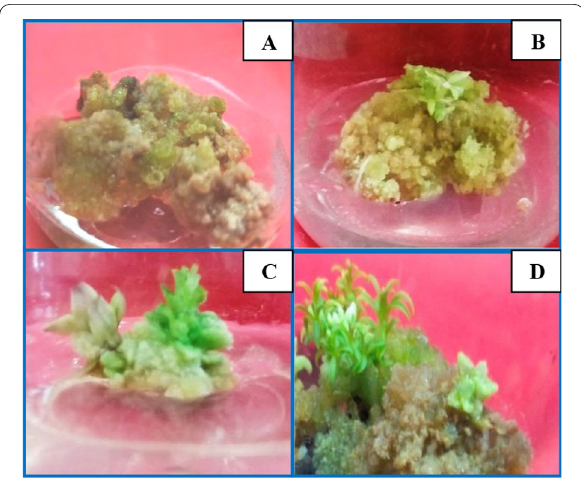
Fig. 4 In vitro regeneration of L. barbarum through callus‑mediated indirect shoot‑organogenic pathway on MS medium containing 176.20 µM TDZ. a : Swilling of callus culture. b : Organogenesis induction of explants. c : New organs began to differentiate on callus surface. d : Further production of organs after the second subculture